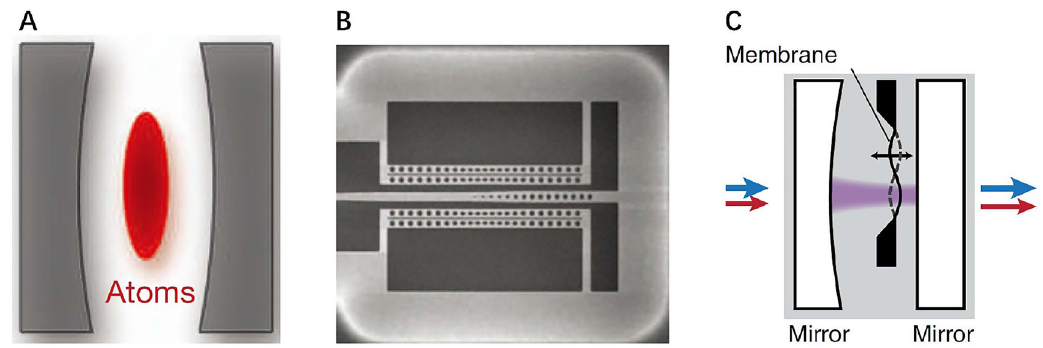
Figure 25: Three types of optomechanical system to realize the squeezed light. (A) Cold-atom optomechanical system [18]. (B) Photonic-crystal cavity optomechanical system [16]. (C) Membrane-in-the-middle optomechanical system